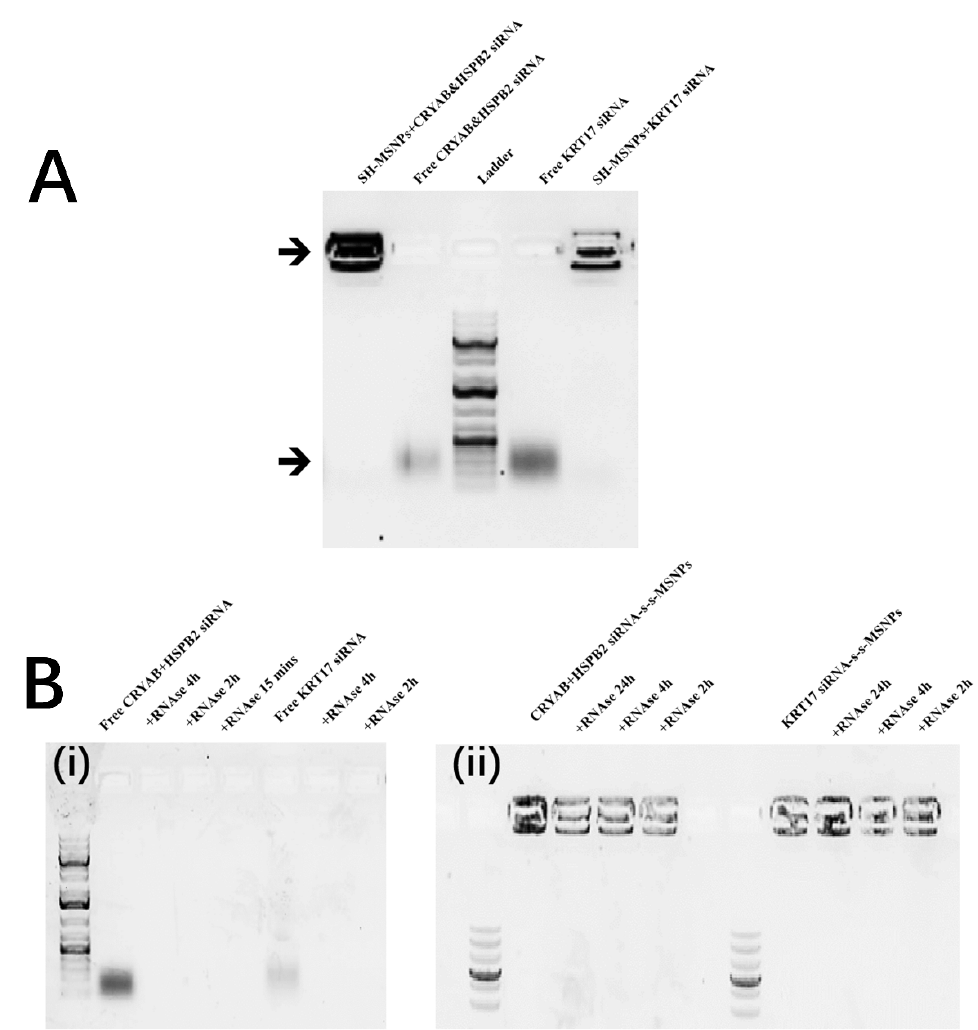
Figure 3. Electrophoresis validation of siRNA linkage and protection by SH-MSNPs ( A ) Validation of siRNA linkage onto the surface of SH-MSNPs electrophoresis gel image of both free CRYAB and HSPB2-targeting siRNA, or KRT17-targeting siRNA and siRNA linked SH-MSNPs for the validation of disulfide bond linkage, cropped gel image. ( B ) Evaluation of siRNA protection after linked onto the surface of SH-MSNPs electrophoresis gel image of (i) free CRYAB and HSPB2-targeting siRNA, or KRT17-targeting siRNA and (ii) siRNA linked SH-MSNPs, treated with same concentration of RNase for different periods of time at 37 ◦ C for the evaluation of degradation prevention after linked with SH-MSNPs, cropped gel image.